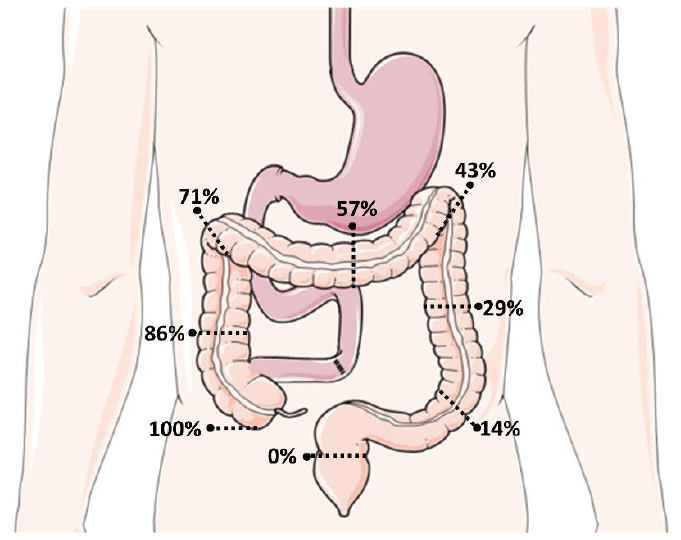
Figure 2. Short Bowel Syndrome with Colon-in-Continuity: preserved colon expressed as % based on Cummings Classification [6].